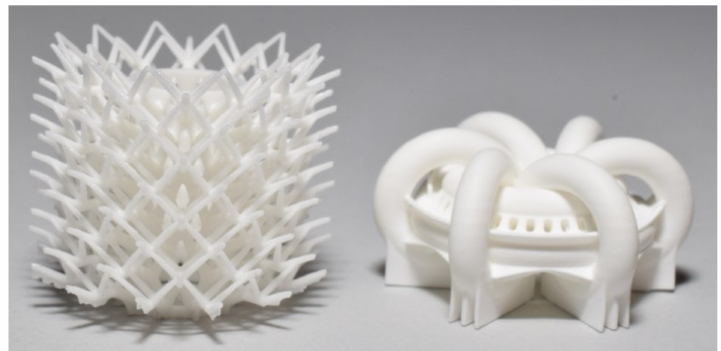
Figure 5. Alumina heat exchangers additively manufactured by lithography-based ceramic manufacturing (LCM) at Fraunhofer IKTS.